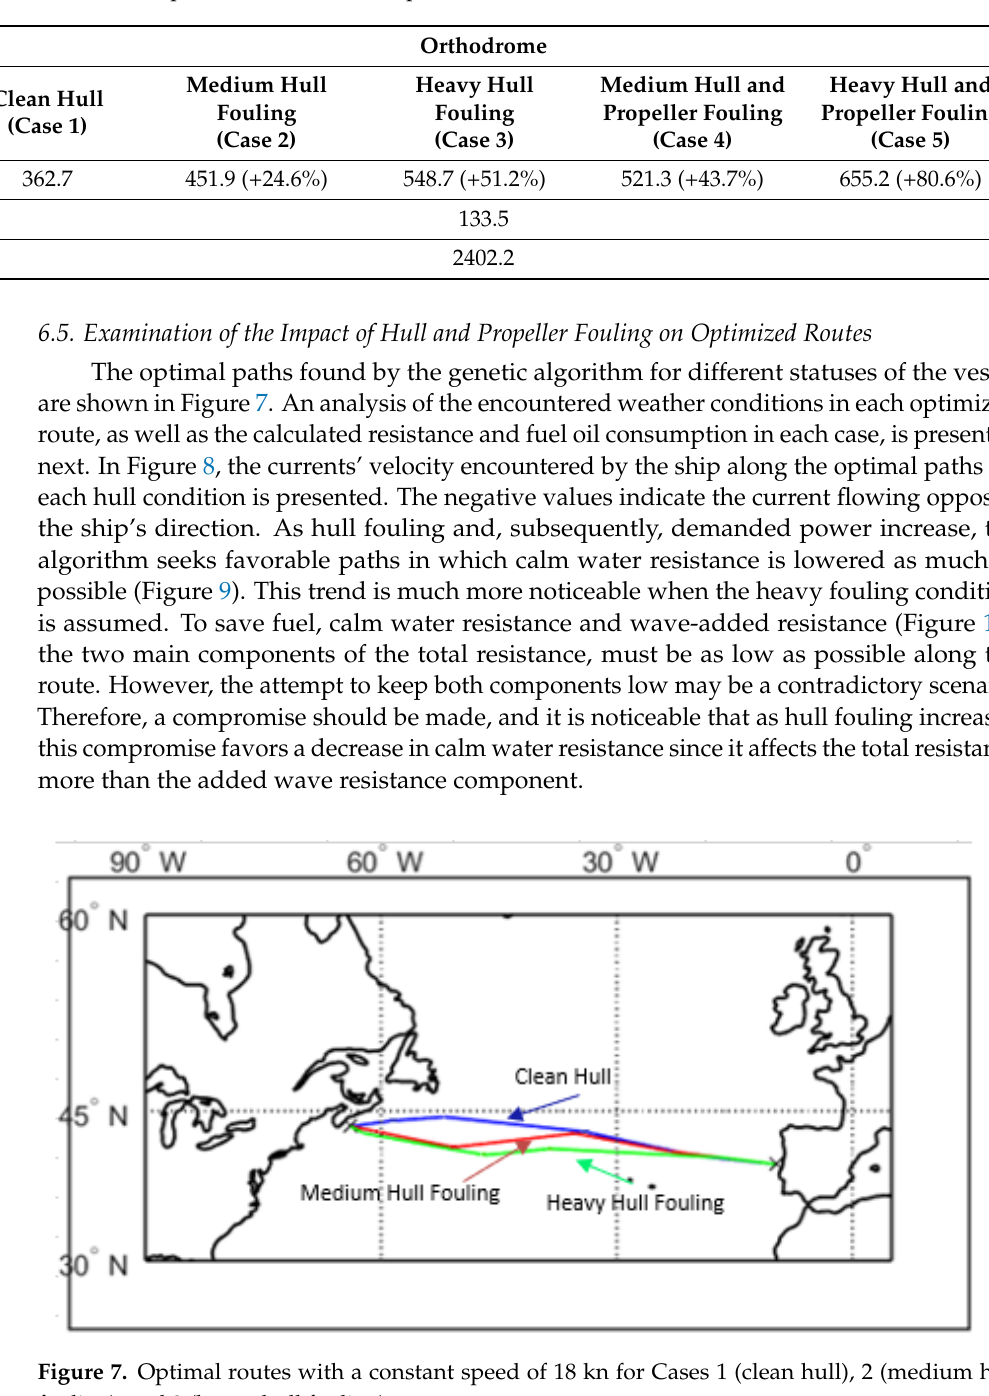
Table 3. Comparison of orthodromic paths.